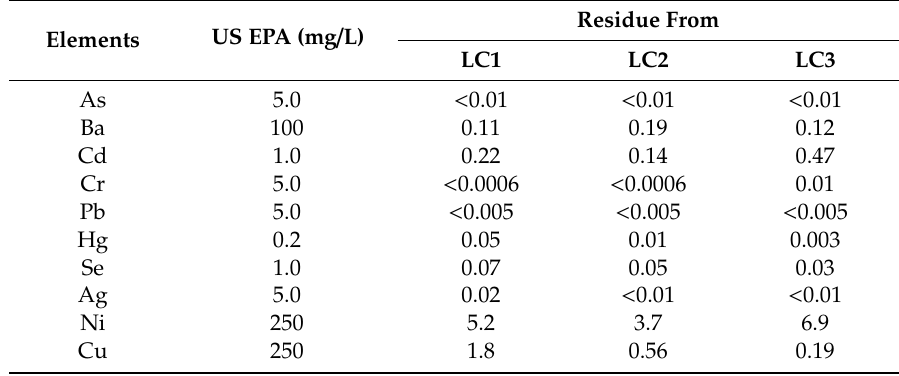
Table 7. Metal concentration in leachate by toxicity characteristic leaching procedure (TCLP) for final